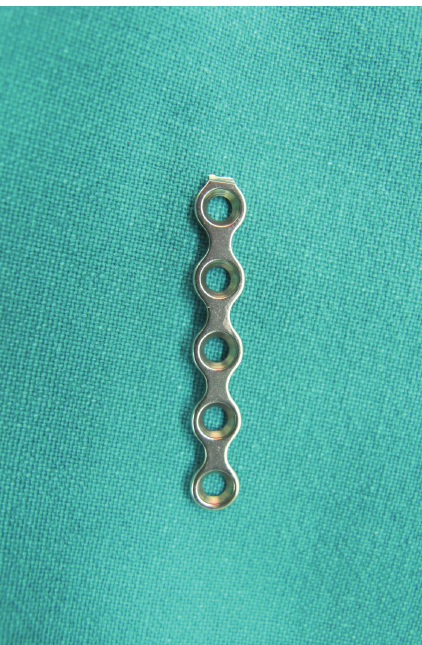
Figure 1: Maxillofacial titanium miniplate.